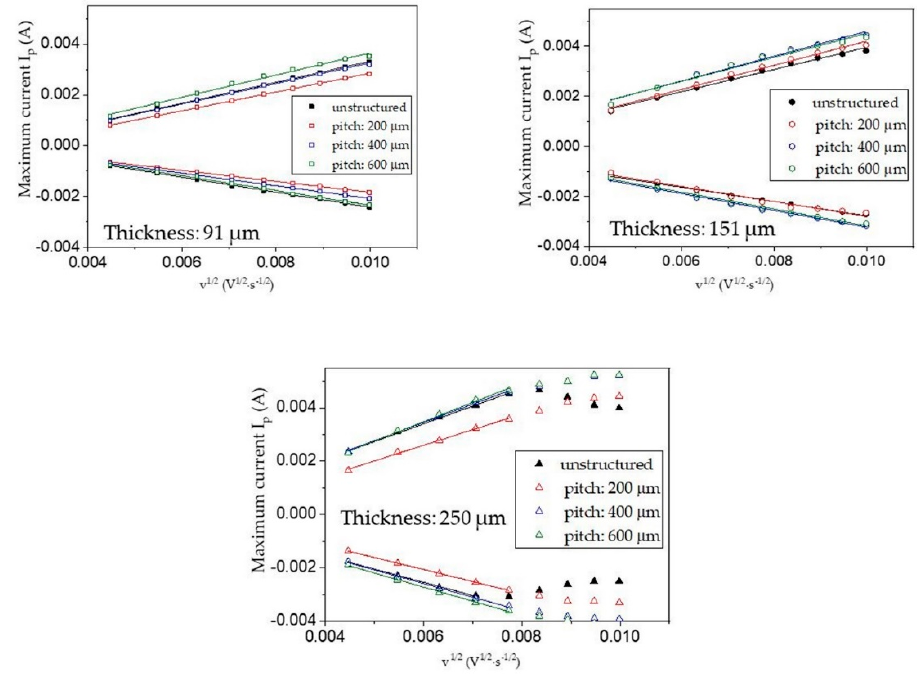
Figure 6. Comparison of the maximum current in relation to the square root of the scan rate for cells containing unstructured and structured cathodes with di ff erent